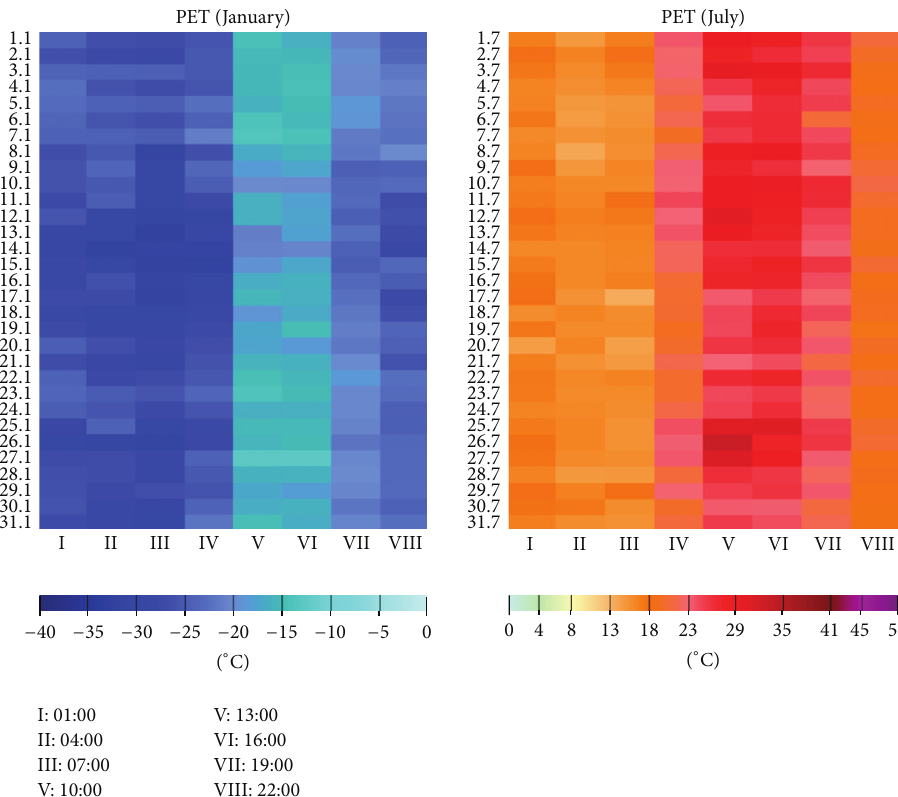
Figure 4: Monthly (along 𝑦 -axis) and daily (along 𝑥 -axis) dynamics of thermal comfort in winter (January) and summer (July) calculated with PET for Birobidzhan, zone 1.